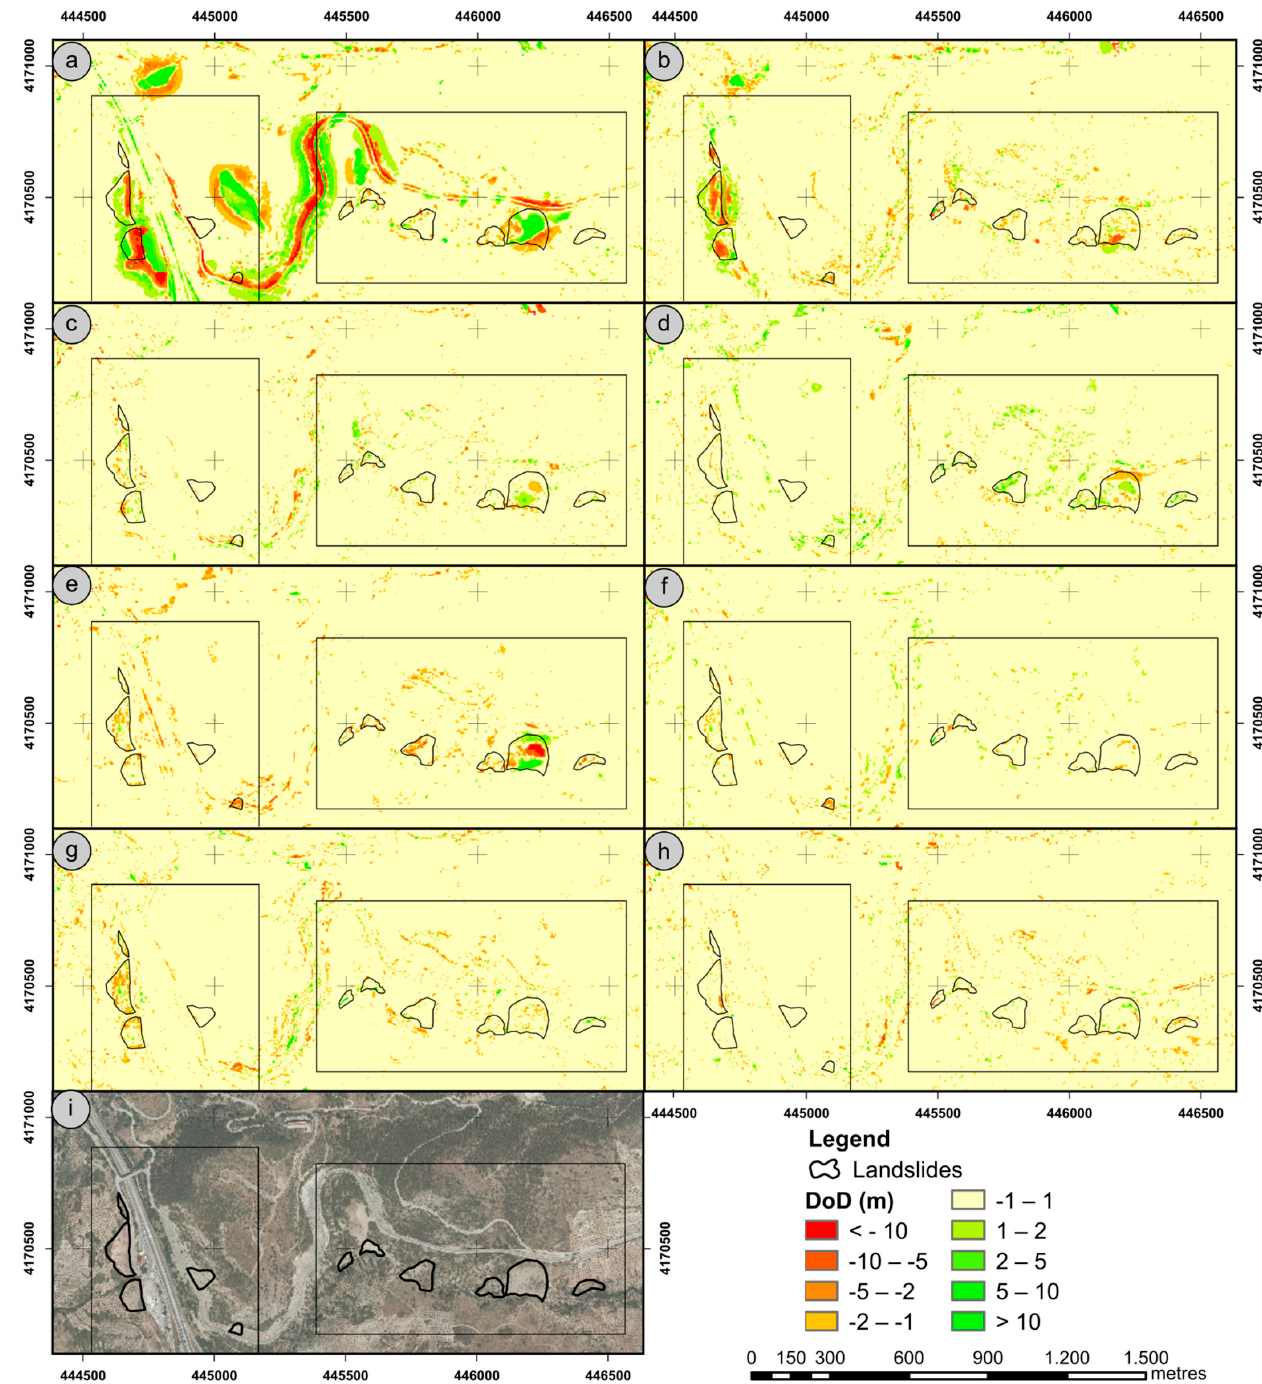
Figure 9. DoDs of areas 9 and 10: ( a ) 1984–1996; ( b ) 1996–2001; ( c ) 2001–2005; ( d ) 2005–2009; ( e ) 2009–2010; ( f ) 2010–2011; ( g ) 2011–2013; ( h ) 2013–2016; ( i ) orthoimage (2016). Coordinates are in ETRS89-UTM30. Locations of area 9 and 10 are shown in Figure 6.